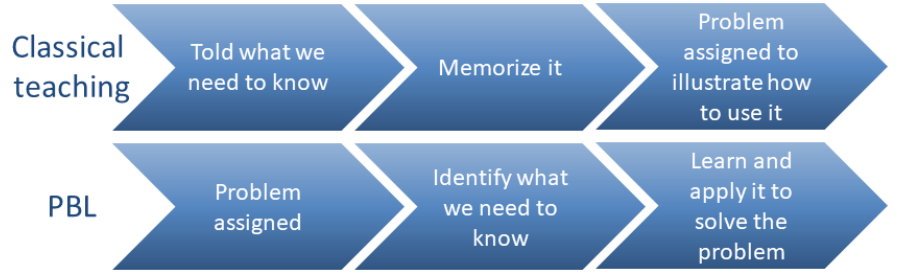
Figure 4. Learning process in classical teaching versus PBL. This figure was made as in [14].